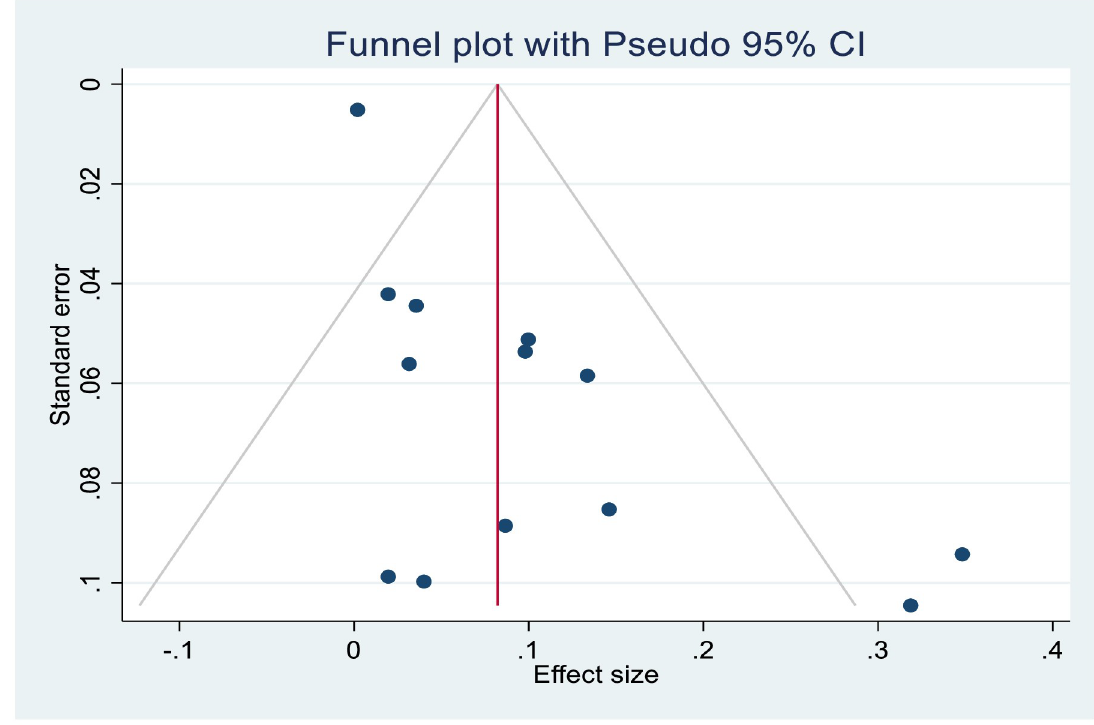
Fig 6. Funnel plot after Duval’s trim and fill